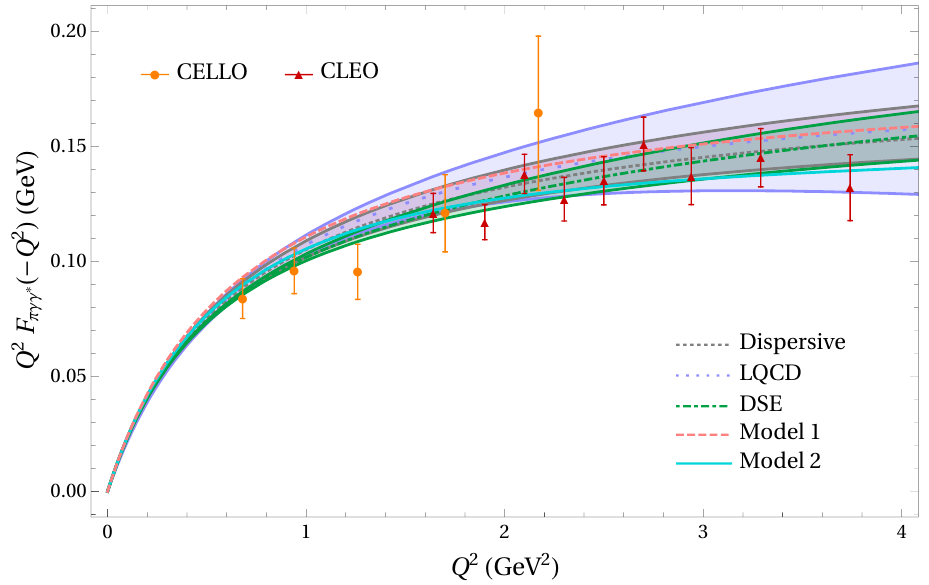
Figure 23. Singly-virtual (cid:25) 0 TFF in the low- Q region. The large- N c Regge model, \Model 1" (4.10), is indicated by the dashed pink curve. Our alternative TFF model, \Model 2" (B.1), is indicated by the solid cyan curve. The gray band with the dotted curve is the dispersive result from refs. [46, 47]. The blue band with the long-dotted curve is the lattice QCD result from ref. [48]. The green band with the dot-dashed curve is the DSE result from ref. [50]. The data are from CELLO [115] and CLEO